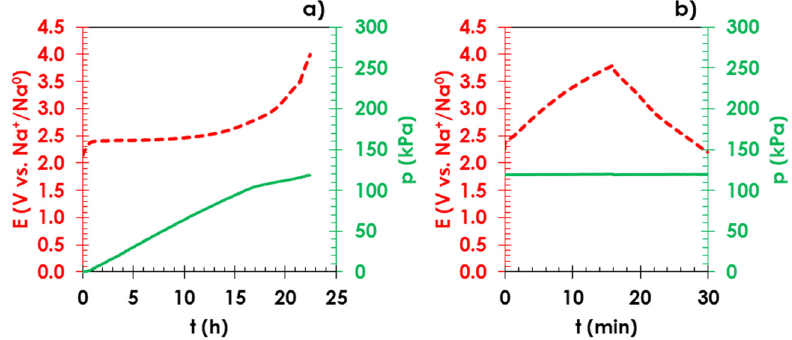
Figure 3: Galvanostatic oxidation of ( a ) NaBH 4 ( red dashed line ) and gas pressure measurement ( green continuous line ) and ( b ) charge/ discharge pro fi le of the positive electrode after the completion of NaBH 4